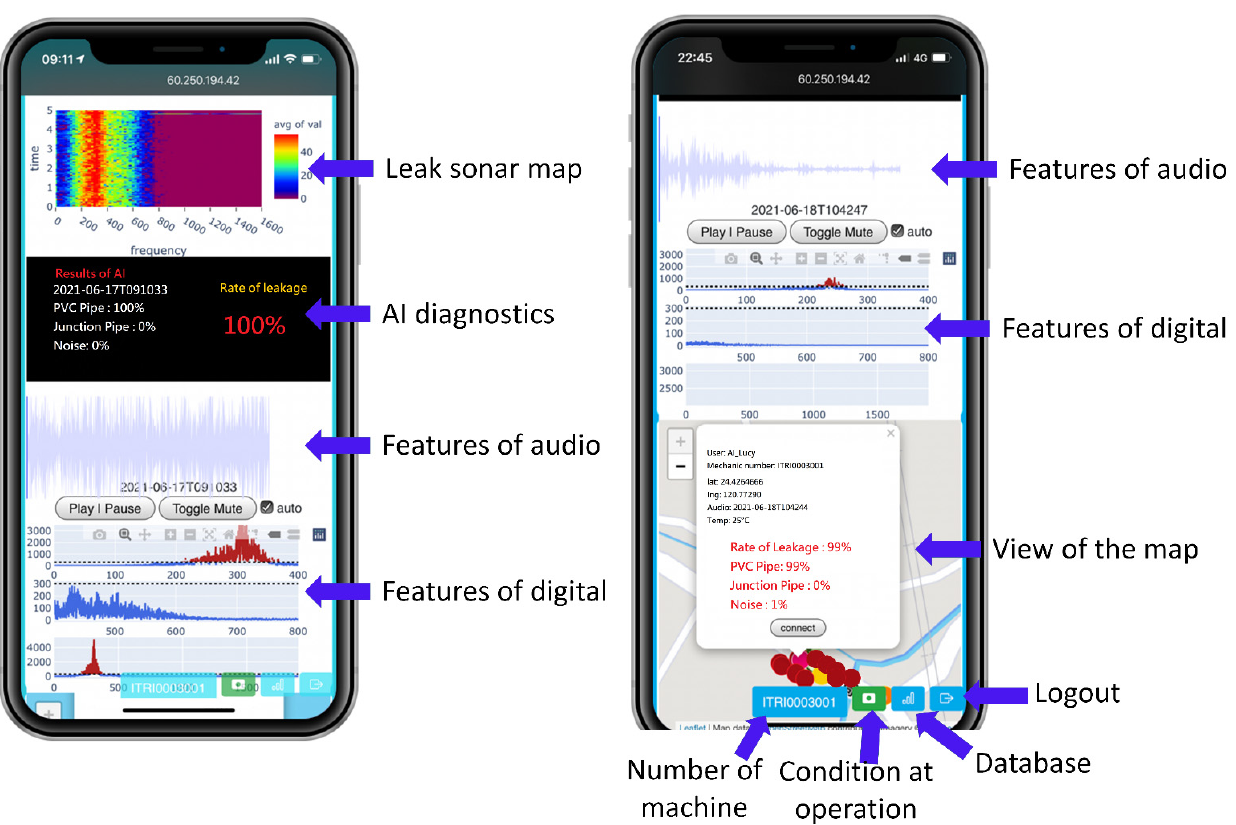
Figure 1. AI-IoT-Based AI Leakage Detection and Localization System.